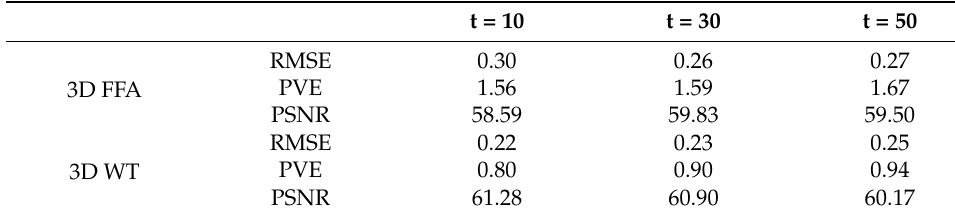
Table 2. Comparison between the 3D FFA method and our method.